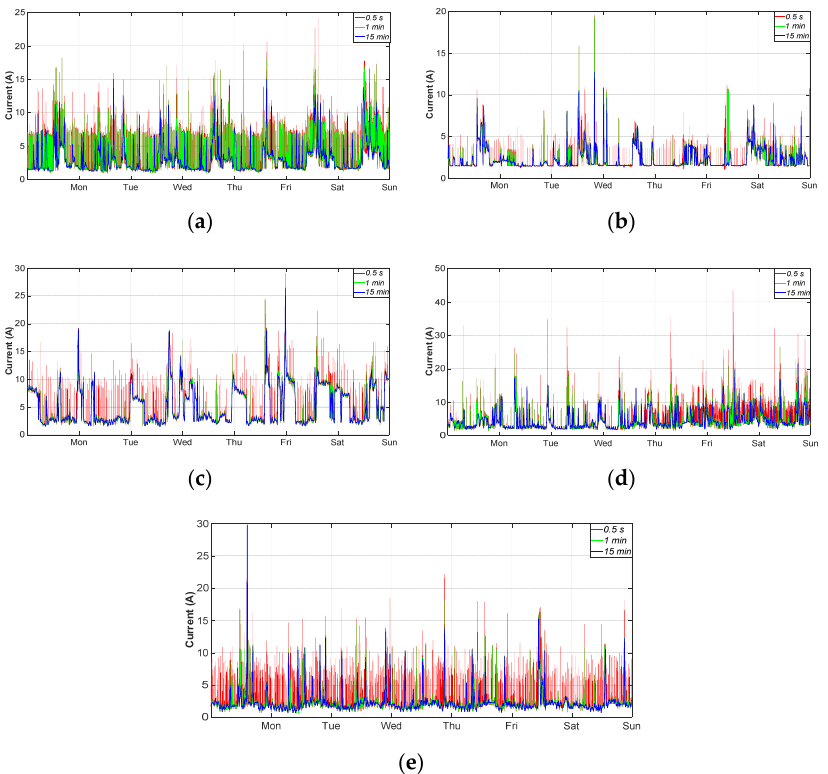
Figure 12. Weekly current distribution: ( a ) Household #1, ( b ) Household #2, ( c ) Household #3, ( d ) Household #4 and ( e ) Household #5.